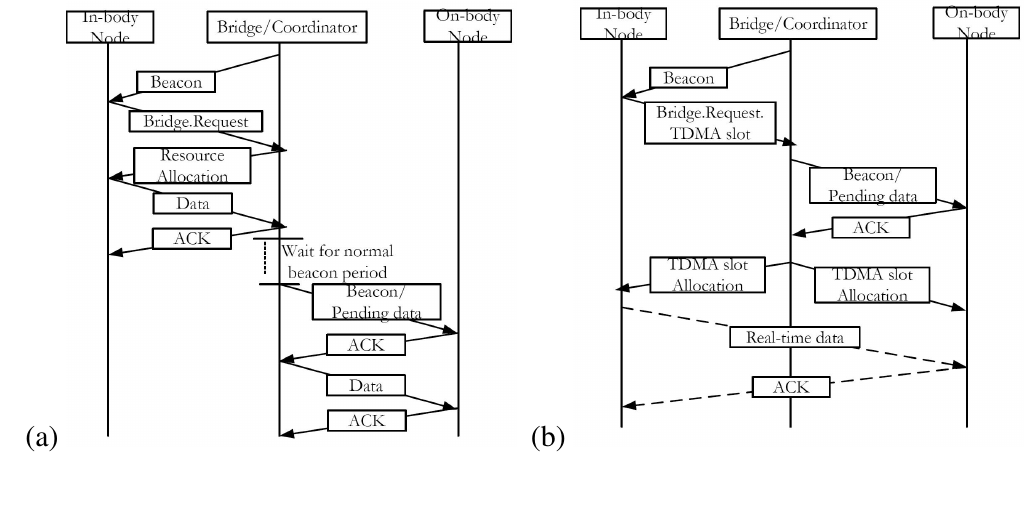
Figure 4. Coordinator as a bridge: (a) The bridge stores and forwards the packet, (b) The bridge establishes a real-time